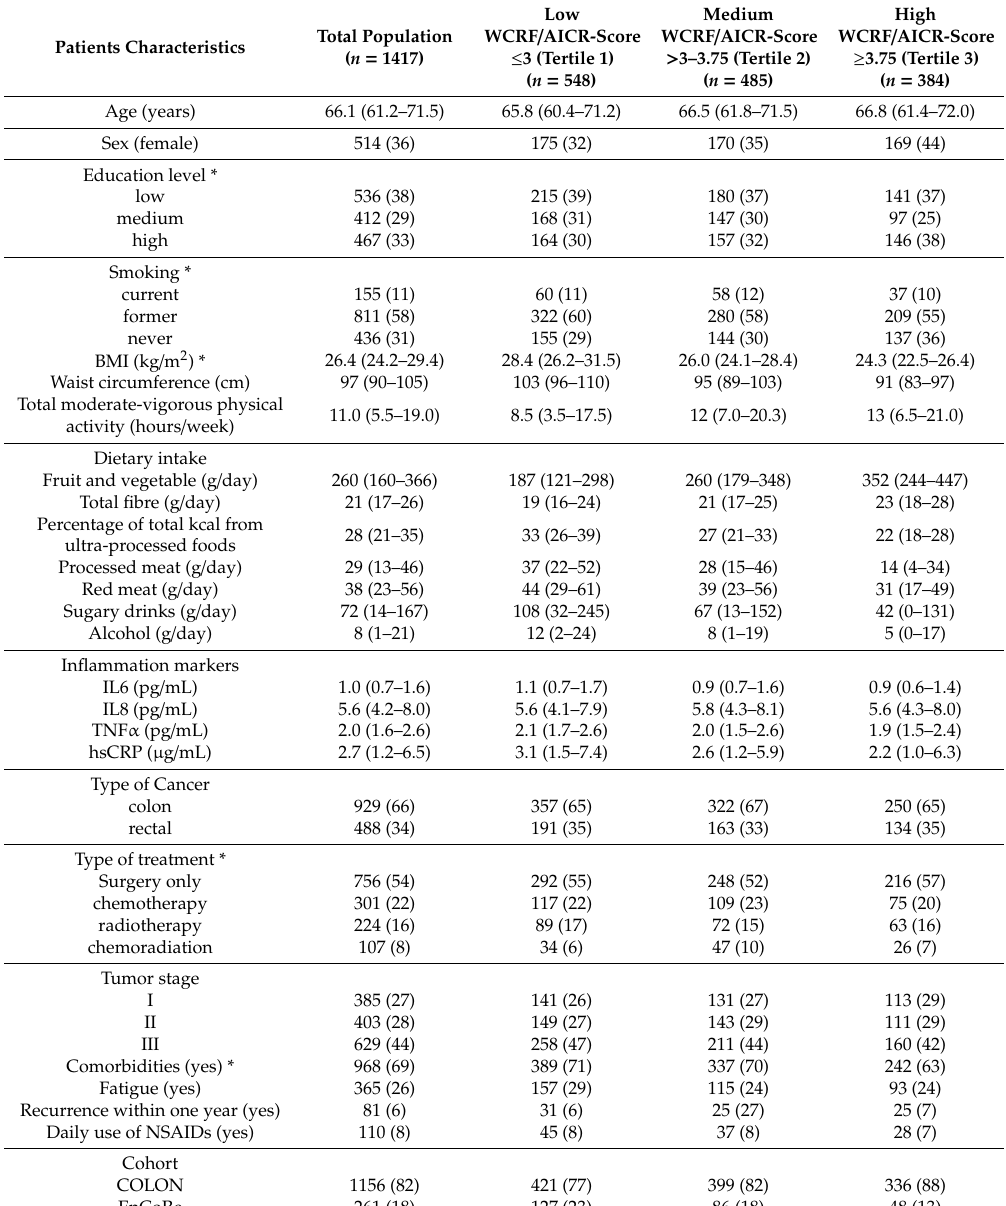
Table 1. Baseline characteristics of colorectal cancer patients stratified for a low, medium, and high World Cancer Research Fund / American Institute for Cancer Research (WCRF /